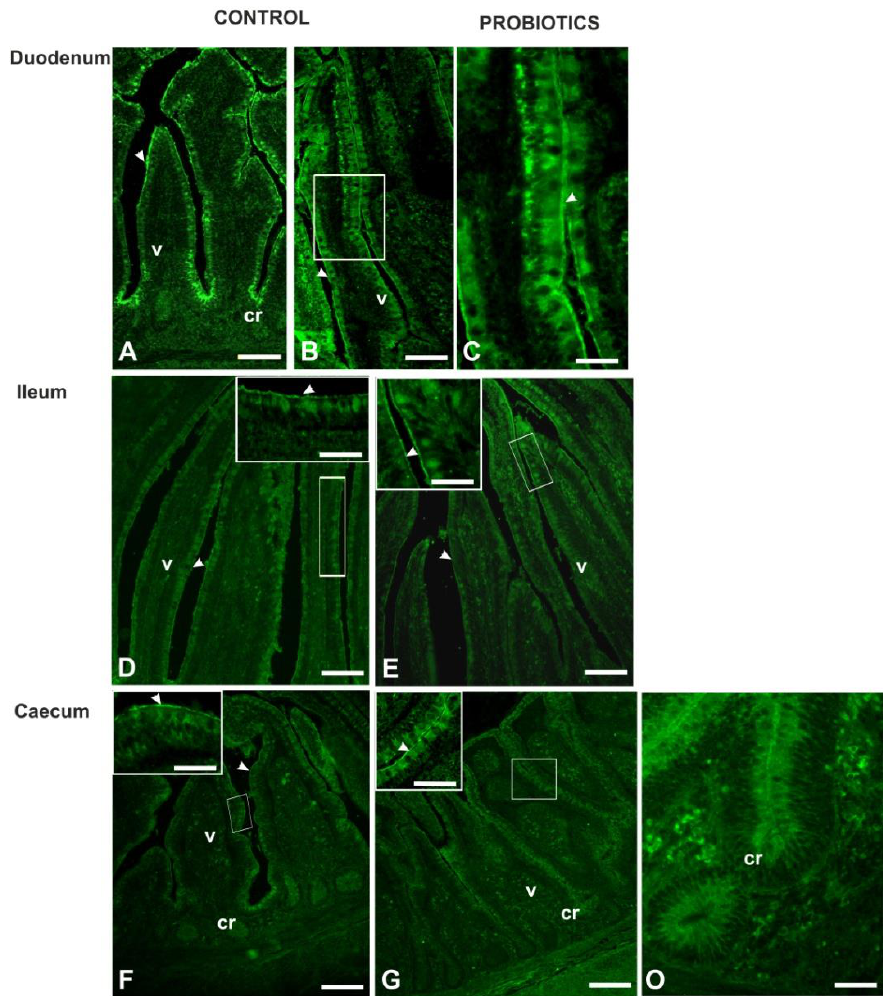
Figure 10. Representative reactivity of Con A with intestinal mucosa of C ( A , D , F ) and P ( B , C , E , G , O ) guinea fowls. C shows high magnification of the square-marked zone from B. Insets in D,E,F,G show detail of marked zones. cr, crypt; v, villus; arrowhead, luminal surface. Scale bars: A,D,E,F,G, 80 µm; B, 100 µm; C, 200 µm; insets D,E,F, 180 µm; O and inset G, 150 µm. Lotus tetragonolonus agglutinin (LTA) bound αL-fucose terminating mucins in GCs of all the intestinal tracts of Cand P guinea fowls, showing an increase in the number of positive GCs moving from duodenum to ileum to caecum (Figure 6). P guinea fowls displayed a significant increase in the number ( p < 0.001) and the fluorescence intensity ( p < 0.05) of LTA-positive GCs in the duodenal tract, and reduction ( p < 0.001) of the staining in ileal and caecal GCs (Figures 6, 7 and 11). The apical surface of the villi and the epi- thelial cells constituting the crypts (Figure 11M) reacted with LTA without significant difference between Cand P samples.